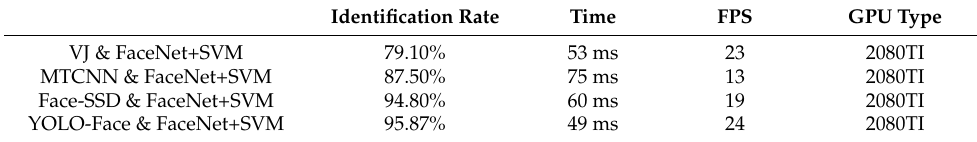
Table 17. Performance of face recognition systems in unconstrained